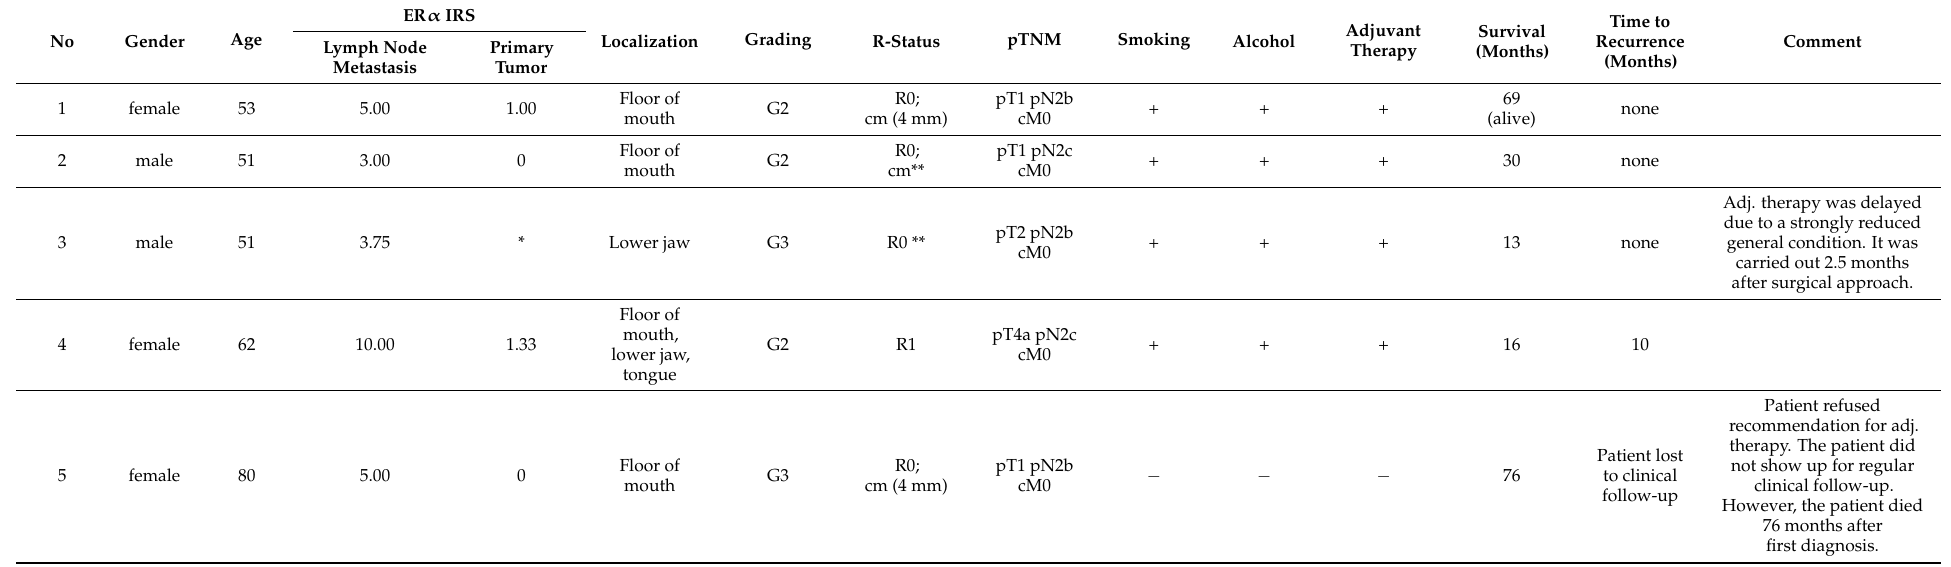
Table 3. Clinicopathological characteristics of all patients with an ER α -positive lymph node